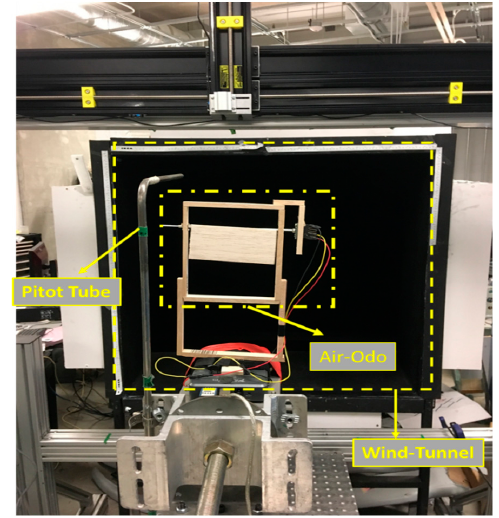
Figure 8. Wind tunnel Air-Odo indoor Experiment to show the relationship between the Air-Odo angles and wind velocity.